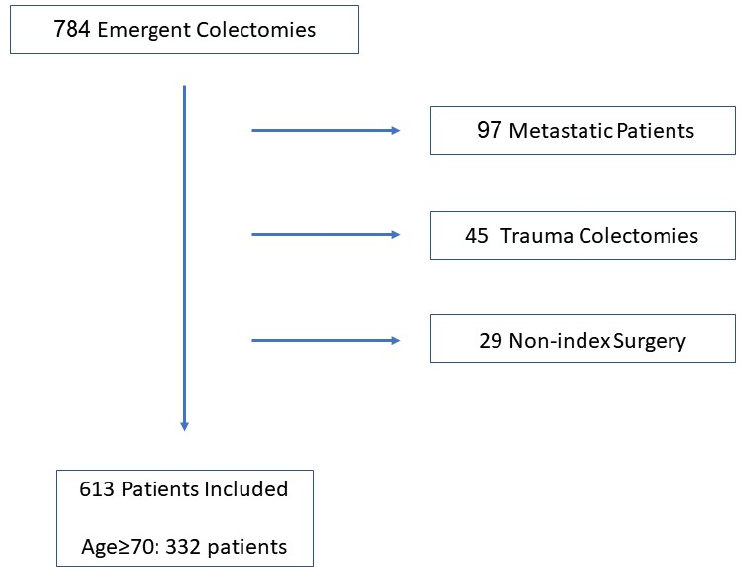
Figure 1. Flow diagram of patient inclusion.